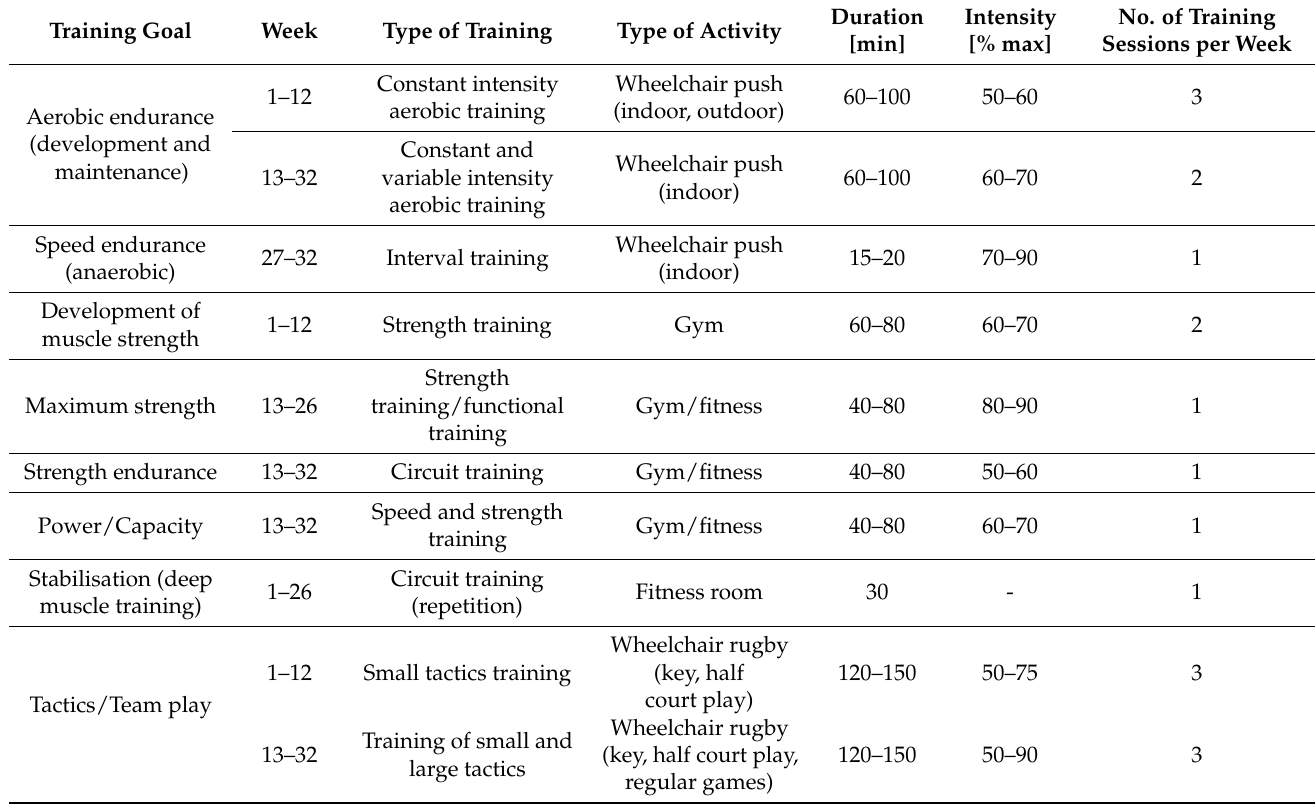
Table 2. Wheelchair rugby players’ weekly training frequency in a macrocycle (training load